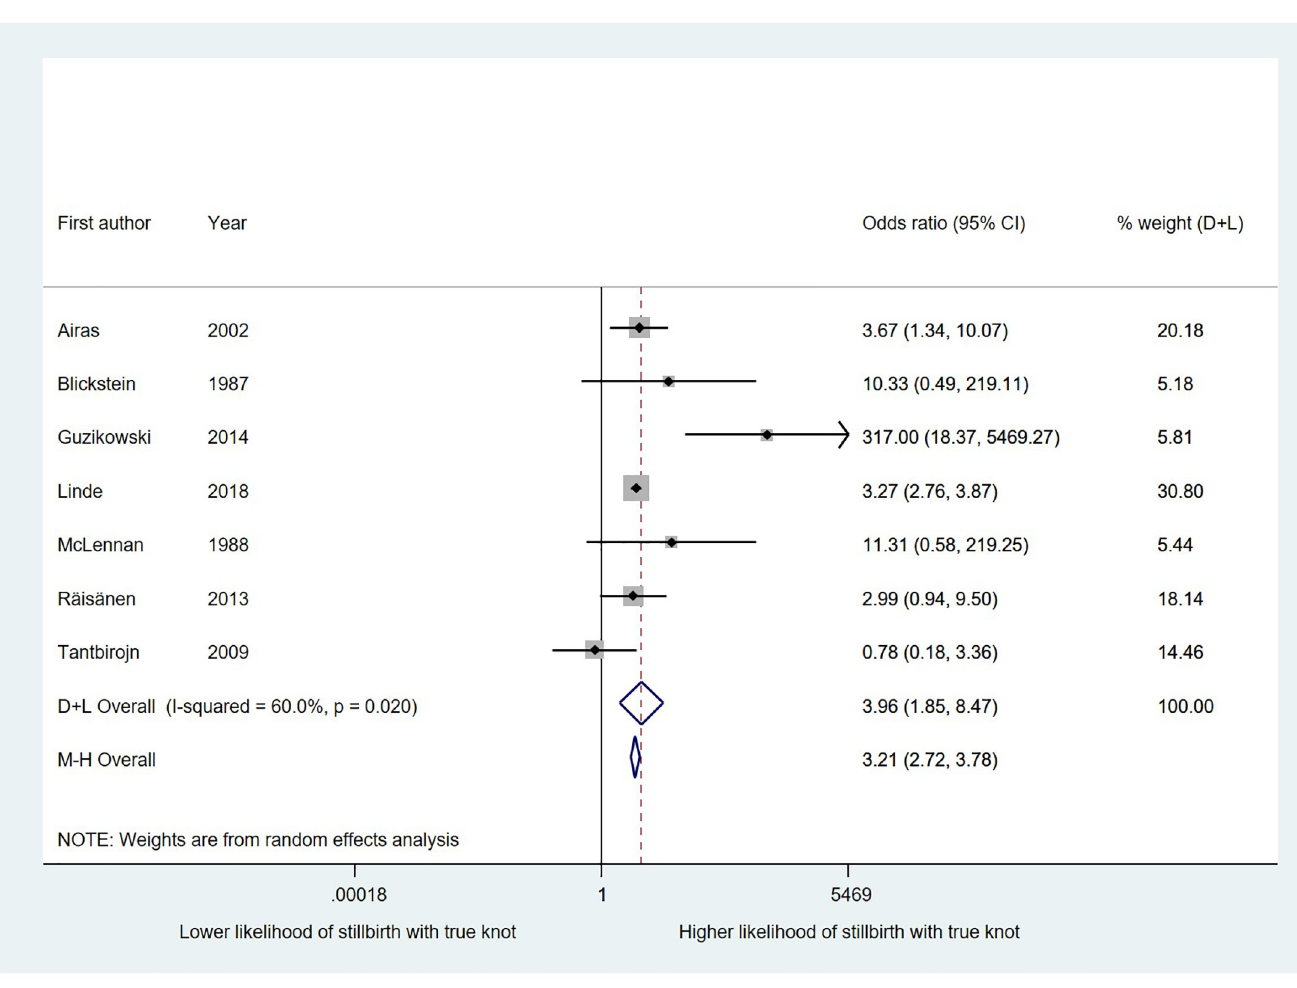
Fig 5. The association between true knots and the likelihood of stillbirth.